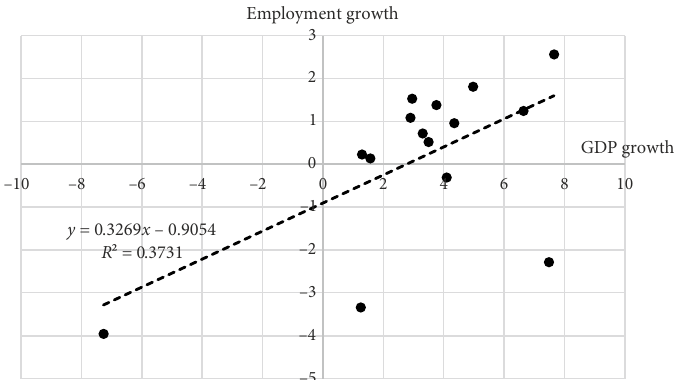
Figure 4. Relationship between average changes in the number of employees and average changes in GDP in CEE countries